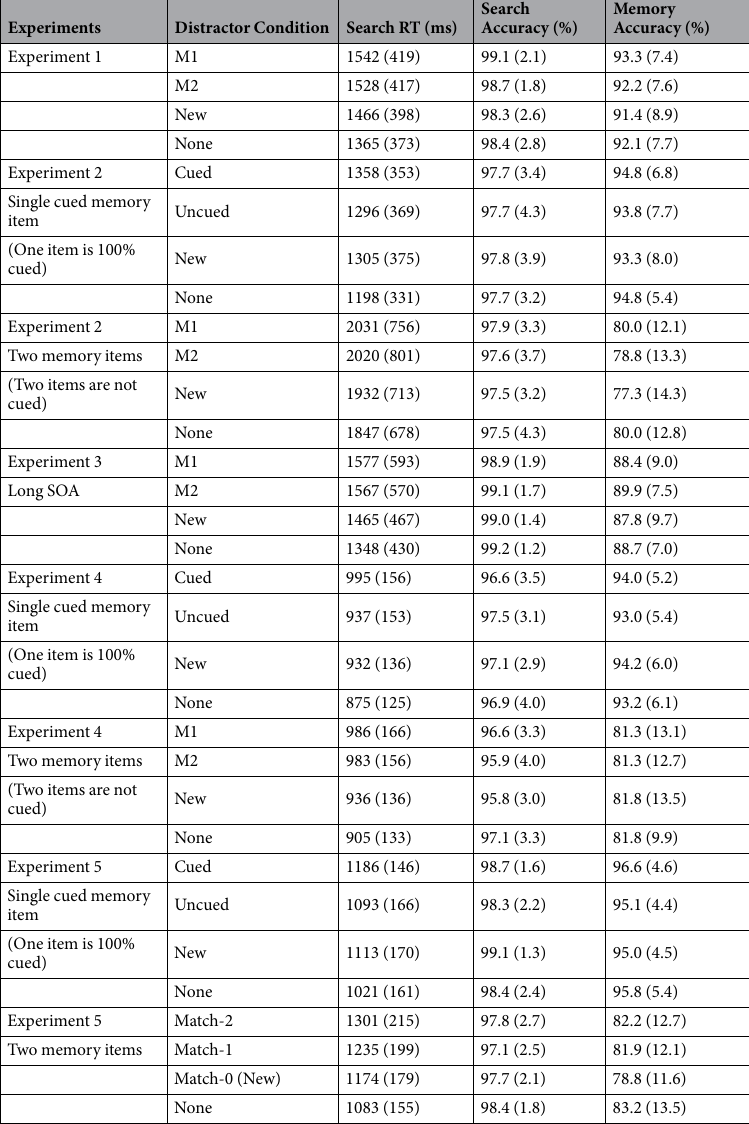
Table 1. Average RTs and mean accuracy for the Search Task, and the mean accuracy for the Memory Task in Experiments 1, 2, 3, 4 and 5. Data between parentheses represents